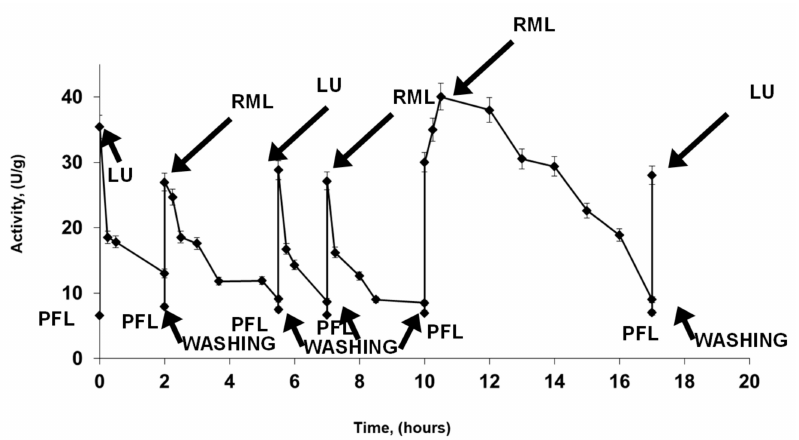
Figure 9. Cycles of reuse of reduced glyoxyl-octyl-PFL in the preparation of combilipases after immobilization of LU or RML and its inactivation and desorption and washing as described in Methods section. PFL is PFL covalently immobilized on glyoxyl-octyl. First cycle: LU was immobilized on reduced glyoxyl-octyl-PFL and inactivated at 50 ◦ C, pH 5; second cycle: fresh RML was immobilized on reduced glyoxyl-octyl-PFL and inactivated at 42 ◦ C, pH 9; third cycle: fresh LU was immobilized on reduced glyoxyl-octyl-PFL and inactivated in presence of 30% acetonitrile at 30 ◦ C, pH 7; fourth cycle: fresh RML was immobilized on reduced glyoxyl-octyl-PFL and inactivated in presence of 40% acetonitrile at 25 ◦ C, pH 7; and fifth cycle: fresh RML was immobilized on reduced glyoxyl-octyl-PFL and inactivated at 55 ◦ C, pH 7. After all inactivations cycles, the lipase preparations were incubated in 4% ( v / v ) of Triton X-100 during 1 h to desorb all lipases hydrophobic adsorbed on the